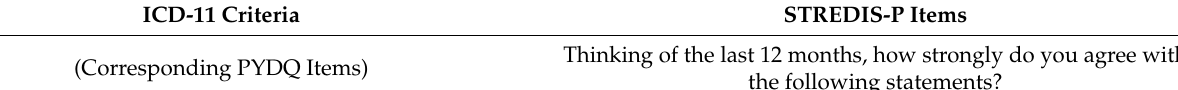
Table 1. STREDIS-P items with corresponding ICD-11 criteria and PYDQ items. ICD-11